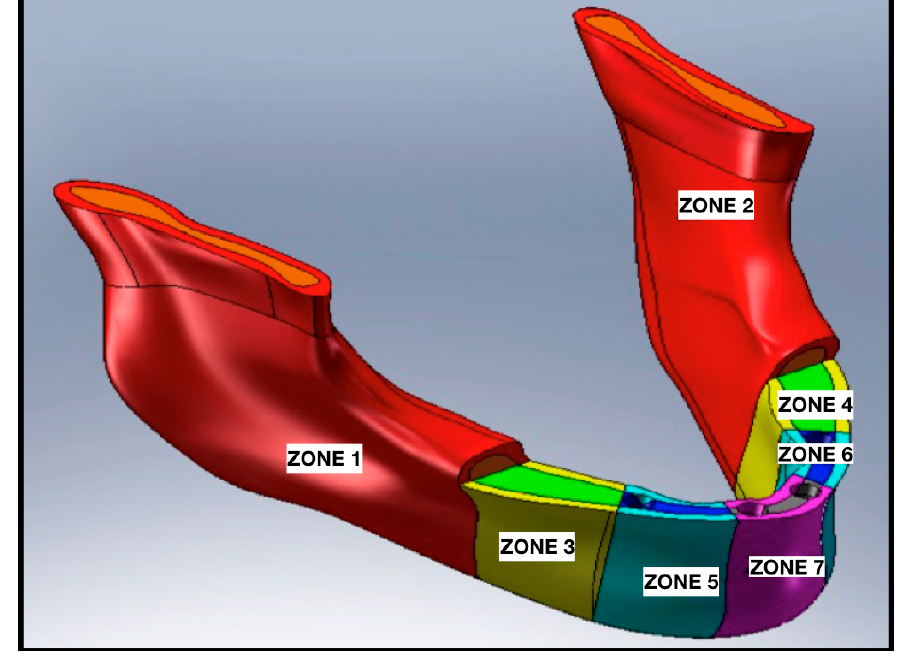
Figure 6. Mandibular model sectioned into different load areas and divided also into cortical and midollar bone, accordingly with literature data. Table 1. Mechanical characteristics of the different areas of mandibular bone and of titanium alloy of the screw [5–10].